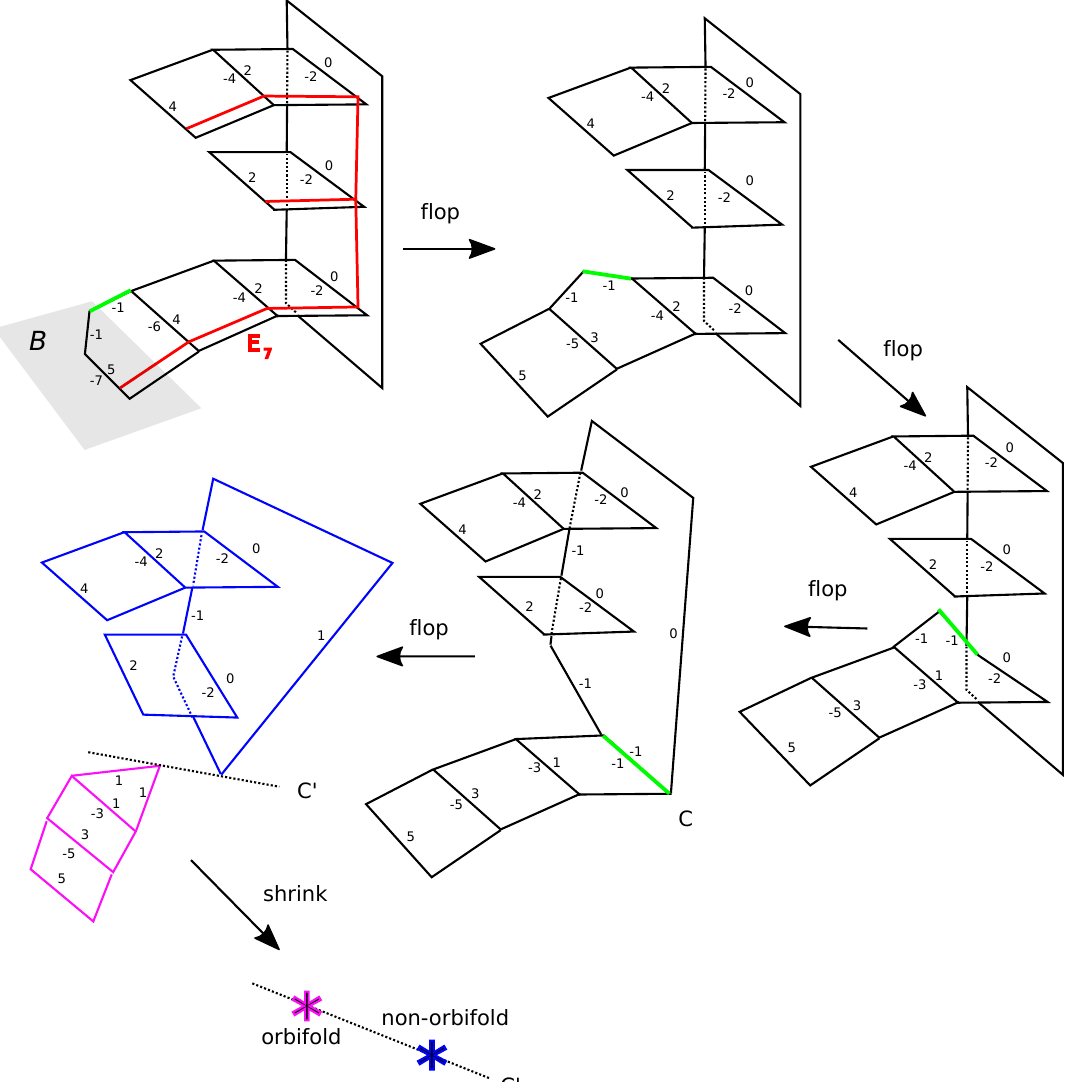
Figure 7 . Geometry of the (cid:0) 7 theory. In red we have indicated the generic E 7 (cid:12)ber along the ruling. We show explicitly the sequence of (cid:13)op transitions leading to the 5D SCFT. In green we have indicate the curve that is being (cid:13)opped at each step. In the 5D limit, the curve C 0 decompacti(cid:12)es. As it is similar to other examples already presented, we have omitted the other 5D SCFT limit described by E 7 gauge theory with a half hypermultiplet in the fundamental